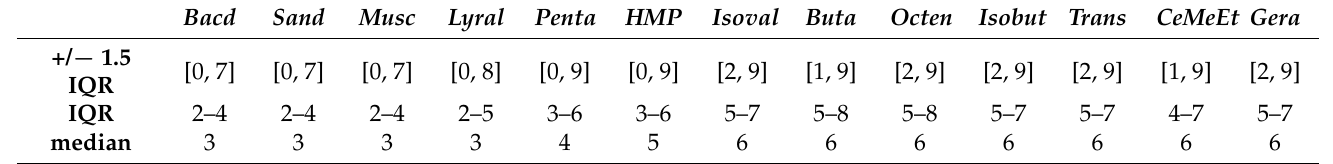
Table 5. Interquartile Ranges for Intensity